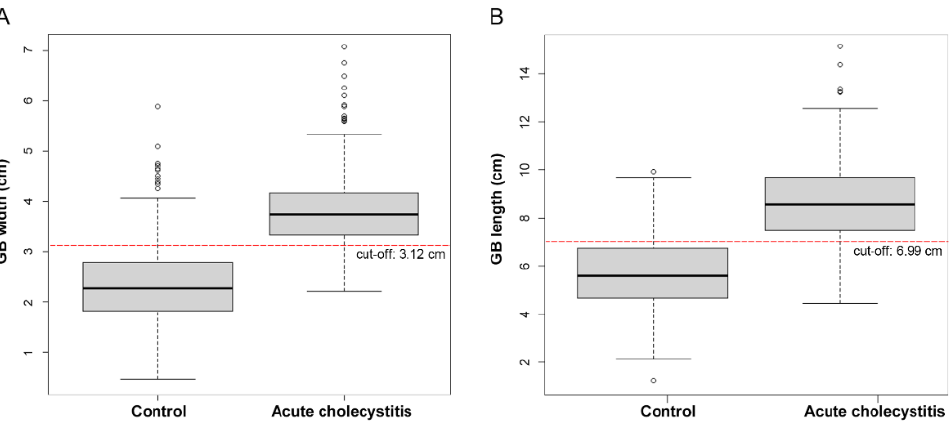
Figure 3. Box plot of acute cholecystitis and control group by gallbladder (GB) width ( A ) and length ( B ). The optimal cut-off values of gallbladder width and length for differentiating acute cholecystitis from the control group determined by assessing the ROC curve were 3.12 cm and 6.99 cm, respectively. Applying this cut-off value of gallbladder width yielded the best sensitivity at 87.8% and specificity at 85.8% for diagnosing acute cholecystitis. None of the patients had acute cholecystitis with a gallbladder width of <2.2 cm. When a gallbladder length cut-off of 6.99 cm was applied, the sensitivity was 82.2%, and specific- ity was 79.9% (Table 2, Figure 4). Table 2. Univariable logistic regression analysis of gallbladder (GB) width and length and acute cholecystitis.